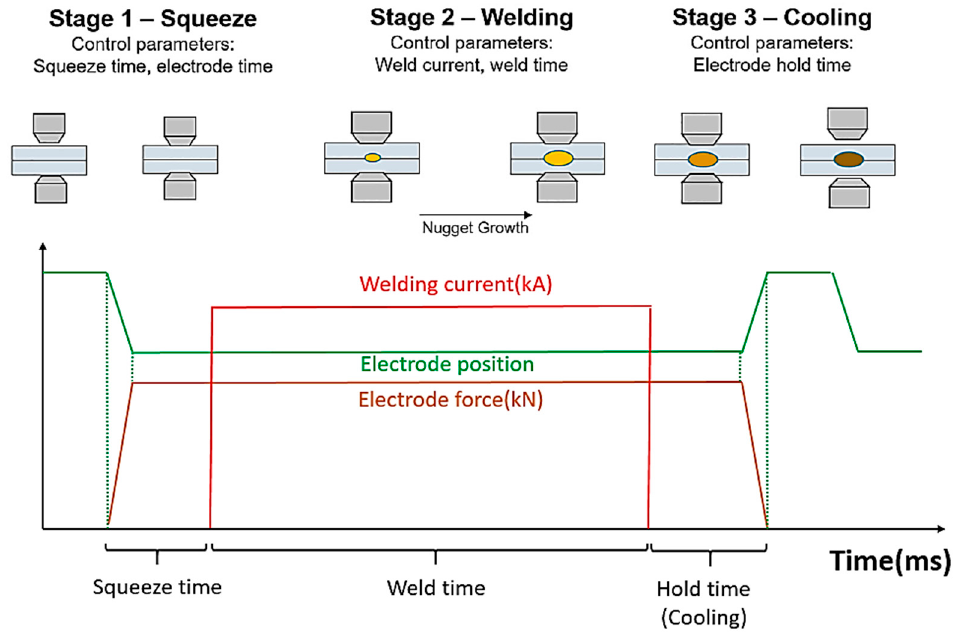
Figure 8. The process of resistance spot welding. Reprinted from [33], with permission of Taylor and Francis, 2018, http://www.tandfonline.com.